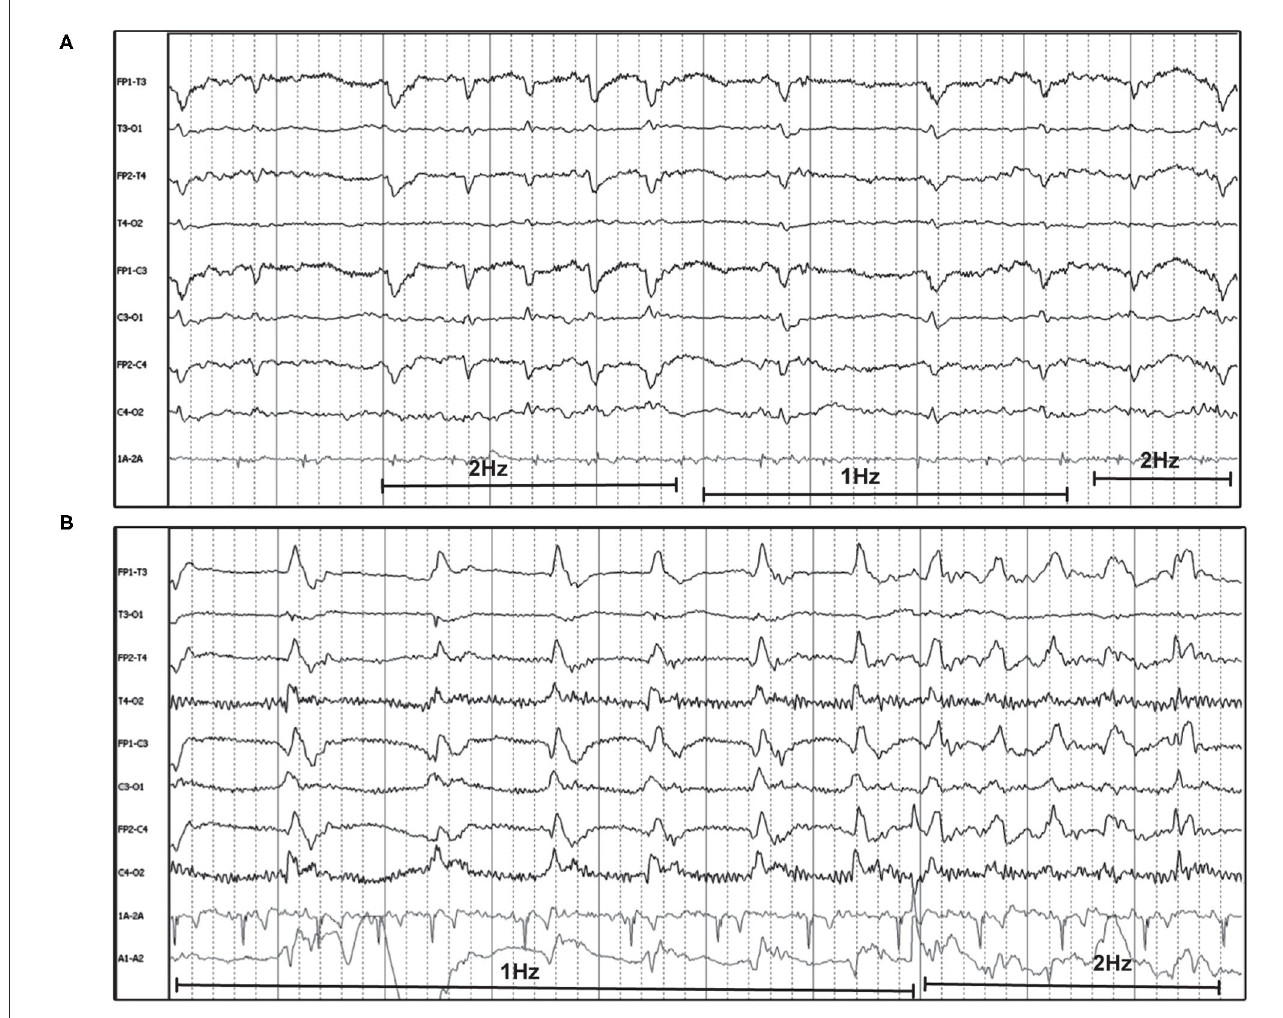
FIGURE9 Two examples of fluctuating frequency of PDs in bipolar montage. (A) Ten year old domestic longhair cat with cluster seizures, unknown etiology (HF 70Hz, sensitivity 10 uV/mm). (B) Two year old beagle with cluster seizures and MUO (HF 15Hz, sensitivity 7 uV/mm). Only two changes in frequency are seen in this epoch, but frequency continued to fluctuate during the